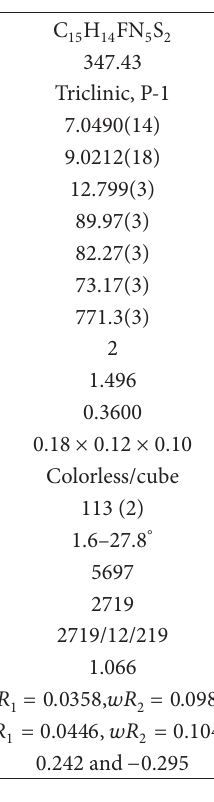
T 1: Crystal structure and data re�nement